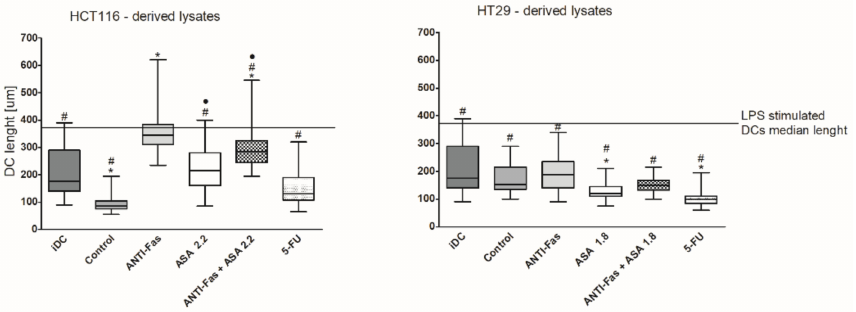
Figure 6. The length [ µ m] of DCs expanded from monocytes and incubated for 24h with LPS or lysates of HCT116 and HT29 cells expanded for 10 days in spherical forms with agonistic anti-Fas antibody (200 ng/mL) and/or aspirin ASA) (2.2 mM or 1.8 mM for HCT116 or HT29, respectively), or 5-FU (50 µ M) in comparison to immature unstimulated DCs (iDCs). DCs incubated with lysates prepared from cancer cells not treated are defined as CONTROL in the Figure. Boxes and whiskers represent min-max, lines–median values. The LPS–stimulated median value of DCs’ length was set on Y-axis. Statistically significant differences were assessed by Kruskal-Wallis test followed by Dunn’s test as a post hoc procedure. (* p < 0.05 vs iDCs, • p < 0.05 ASA vs ASA/anti-Fas antibody, # p < 0.05 vs LPS, n = 60–80 of each option). Three independent experiments were